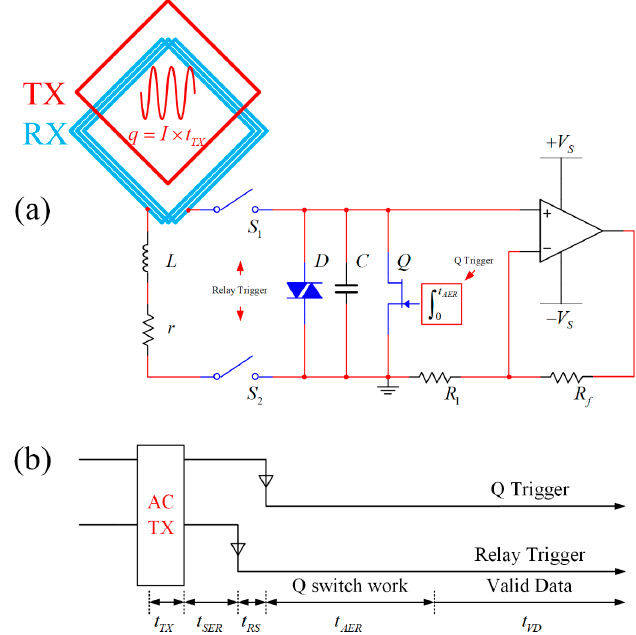
Figure 6. Front-end circuit of the receiver and work time sequence (Tx and Rx coils are overlapped, Rx coil is equal to L and r in series, S 1 and S 2 are relays, and D , C and Q are in parallel; the work time sequence contains time slices of a circle with multiple functions). ( a ) Front-end circuit of the receiver; ( b ) Work time sequence.